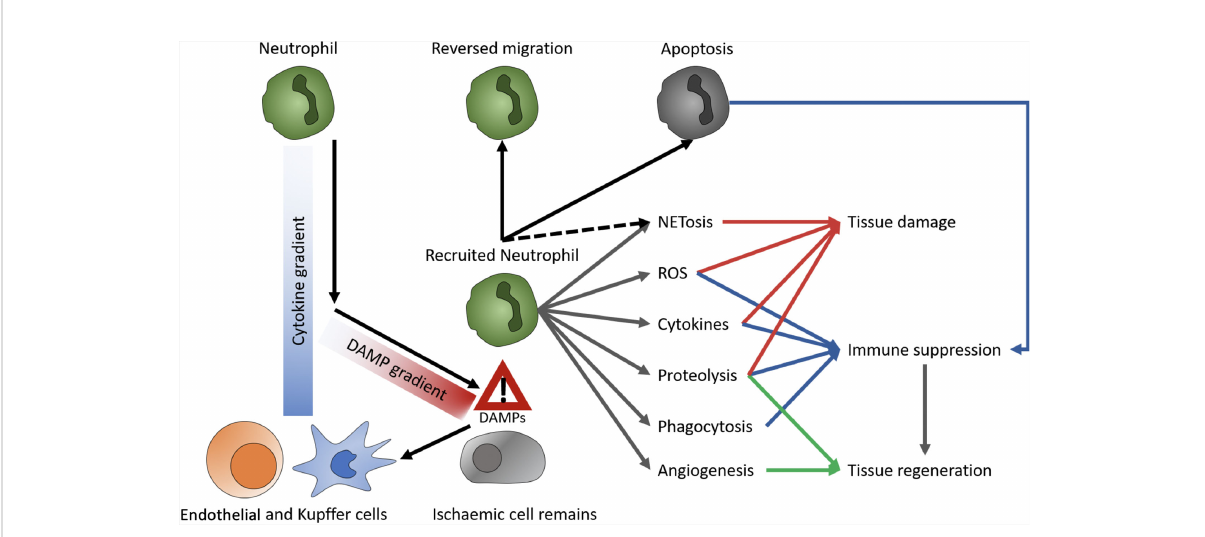
FIGURE 2 Role of neutrophils. DAMPs, danger- or death-associated molecular patterns; ROS, reactive oxygen species; NETs, neutrophil extracellular